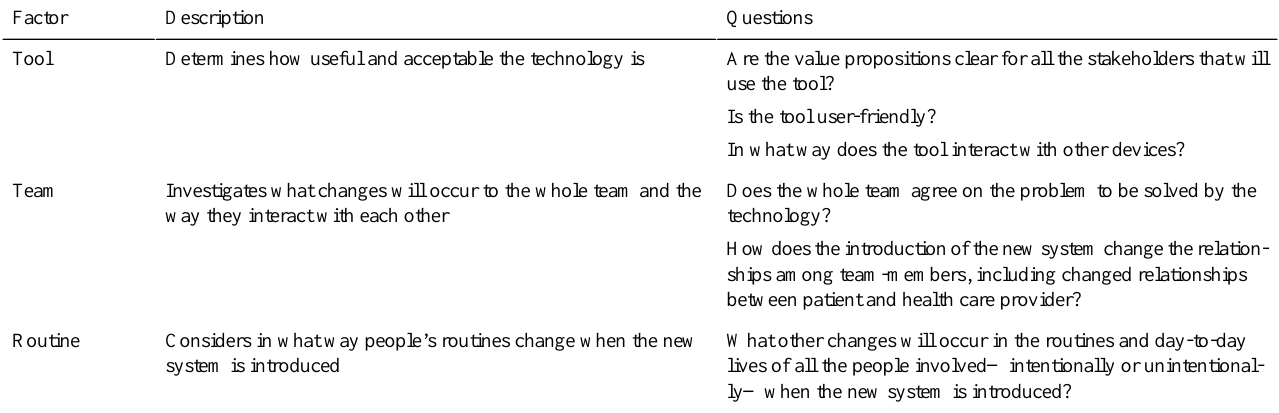
Table 1. Tool+Team+Routine framework.